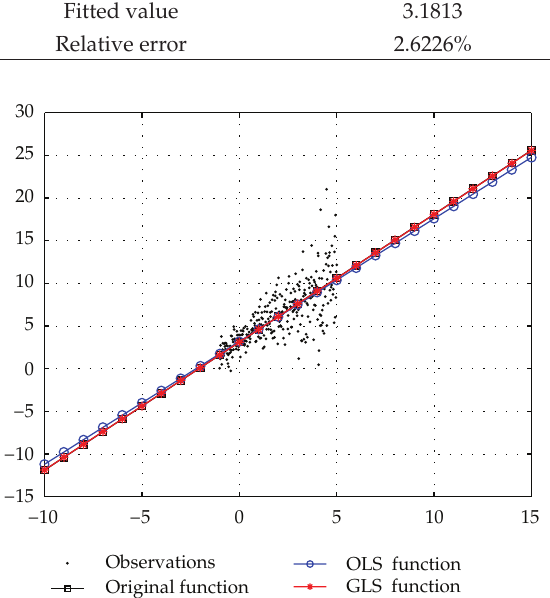
Figure 4: Curves of original and regression functions estimated by GLS and